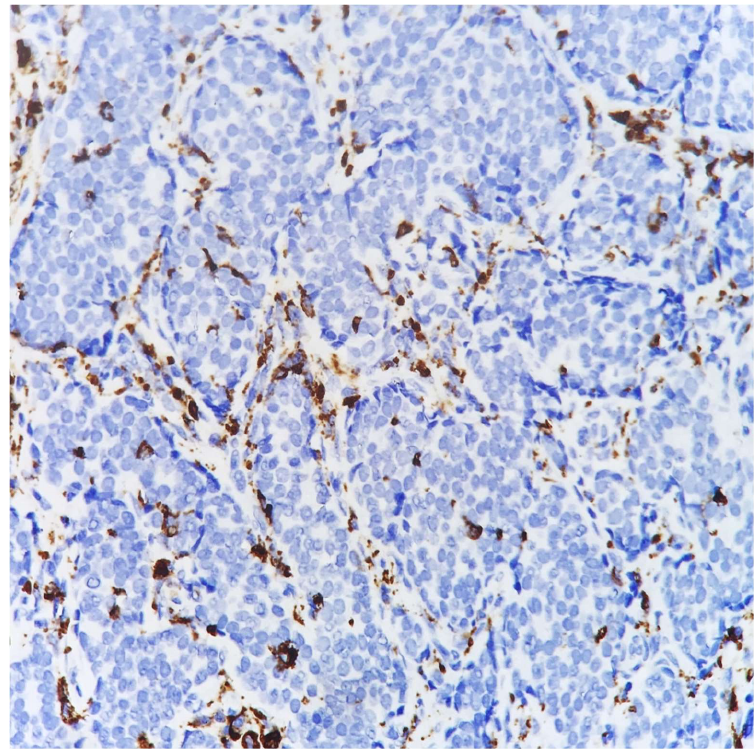
Figure 5. Histological detail of surgical specimen showing absence of stromal osteoclast-like giant cells, demonstrated by immunoreaction for CD68. Many CD68-positive macrophages were still de- tectable (400×).